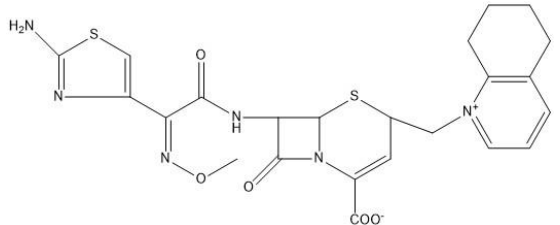
Figure 1. Chemical structure of cefquinome.